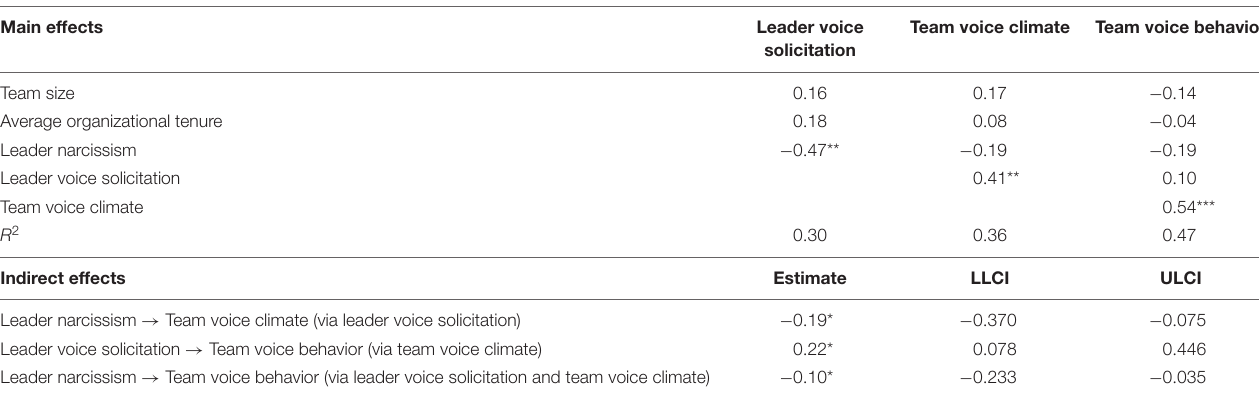
TABLE 2 | Results of the path